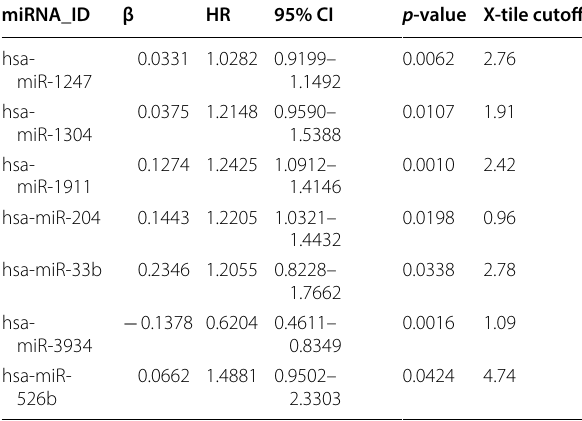
β prognostic regression coefficient; HR hazard